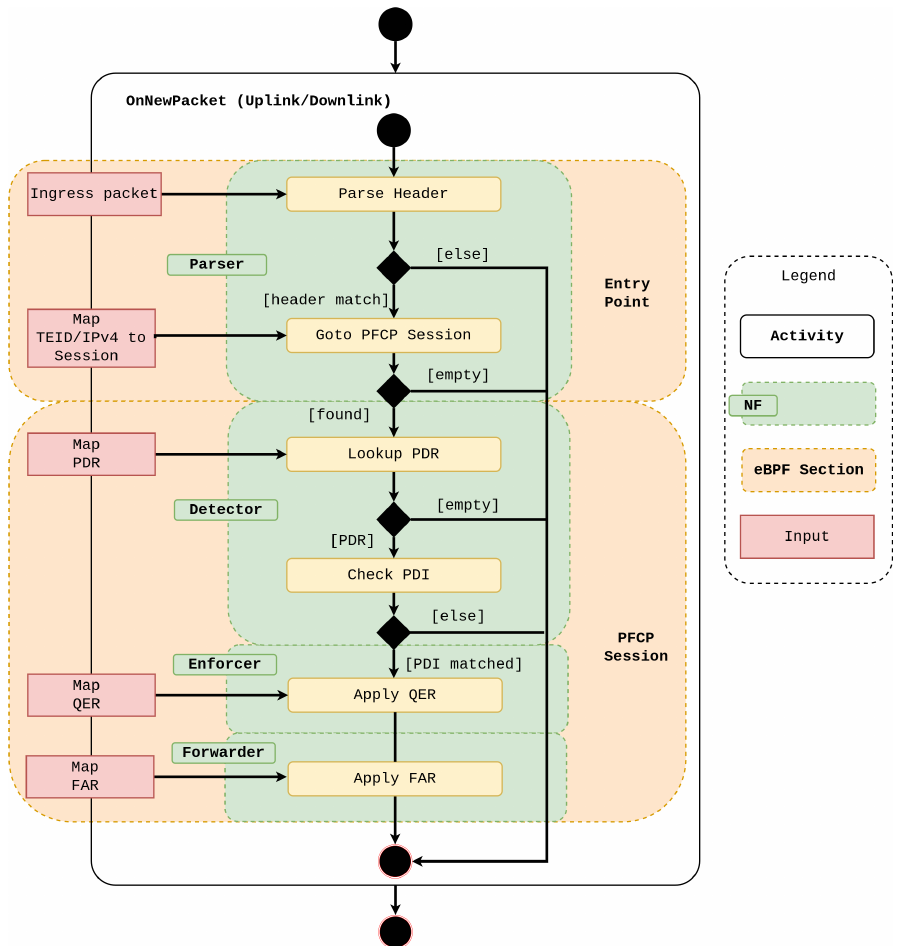
Figure 11. Workflow in Datapath Layer with QER and FAR (version